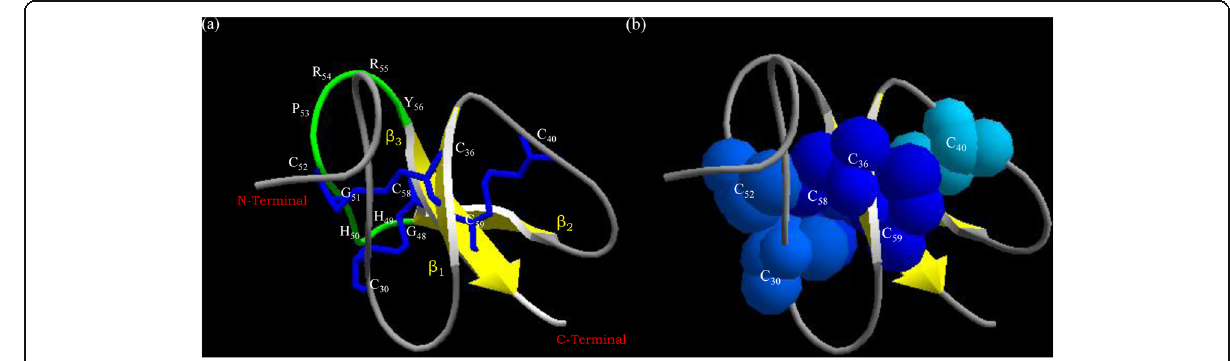
Fig. 6 a Predicted β -defensin domain model for Odonus niger β -defensin ( On -Def) by I-TASSER. The three β -strands are denoted yellow with the three disulfide bonds (blue) stabilizing the β -defensin fold. The C-terminal β -strand ( β 3) is trapped between the other two β strands ( β 1 and β 2) by the β -hairpin G 48 – Y 56 (green) forming the typical anti-parallel β -defensin structure. b The buried position of cysteine residues with their disulfide bonds were computed using the accessibility color tool of Swiss PDB Viewer 4.1, which displays accessibility of residues ranging from deep blue (most buried) to red (most